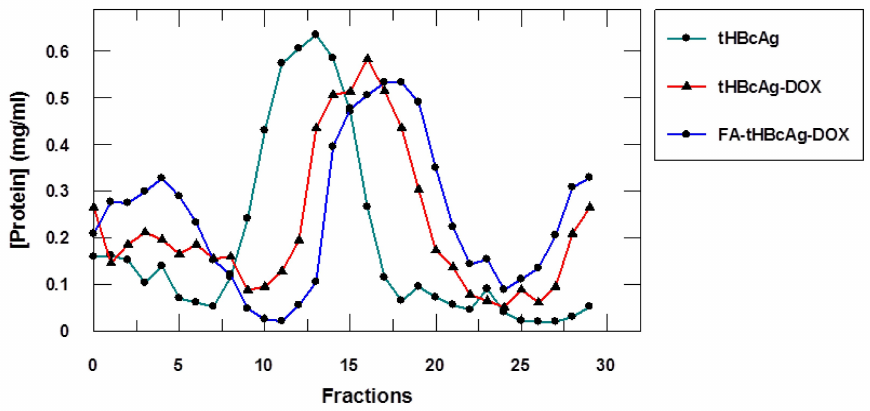
Figure 3. Migration profile of the tHBcAg VLNPs conjugated with doxorubicin (DOX) and folic acid (FA) in the sucrose gradient. tHBcAg VLNPs (tHBcAg), tHBcAg VLNPs conjugated with DOX (tHBcAg-DOX), and tHBcAg VLNPs conjugated with DOX and FA (FA-tHBcA-DOX) were separated on sucrose gradients, and the total amount of protein in each fraction was measured using the Bradford assay. tHBcAg served as a negative